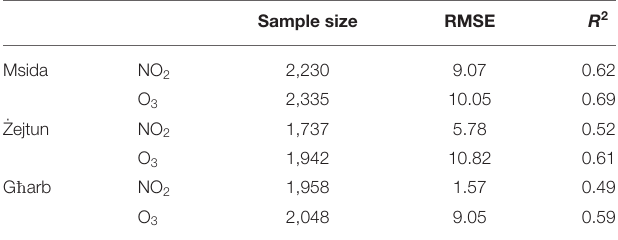
TABLE 1 | Statistics showing model performance for each of the model grown between 2008 and 2017. Sample